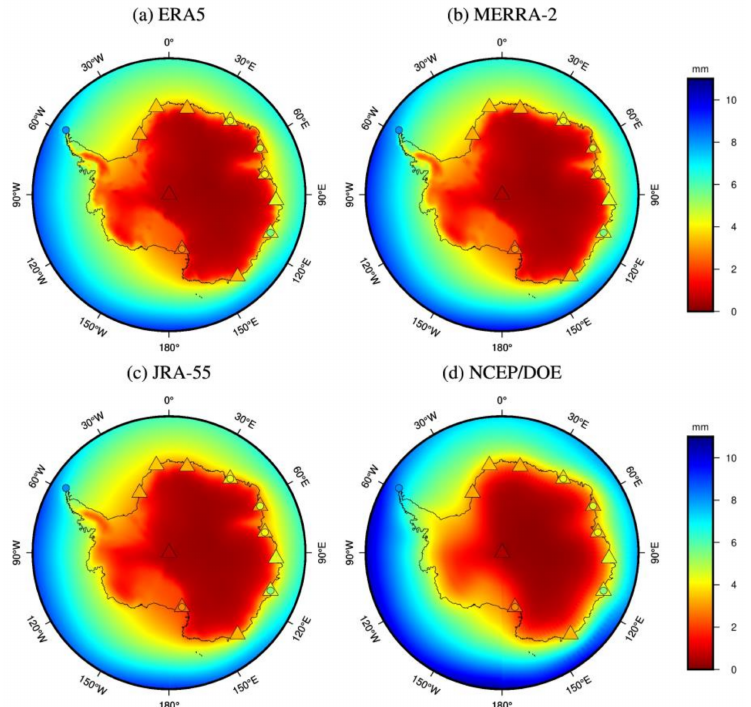
Figure 8. Spatial distribution of PWV means over Antarctica for 2001 to 2018 derived from ( a ) ERA5, ( b ) MERRA-2, ( c ) JRA-55, ( d ) NCEP/DOE reanalysis (color shading), GNSS (color circles) and radiosonde (color triangles).